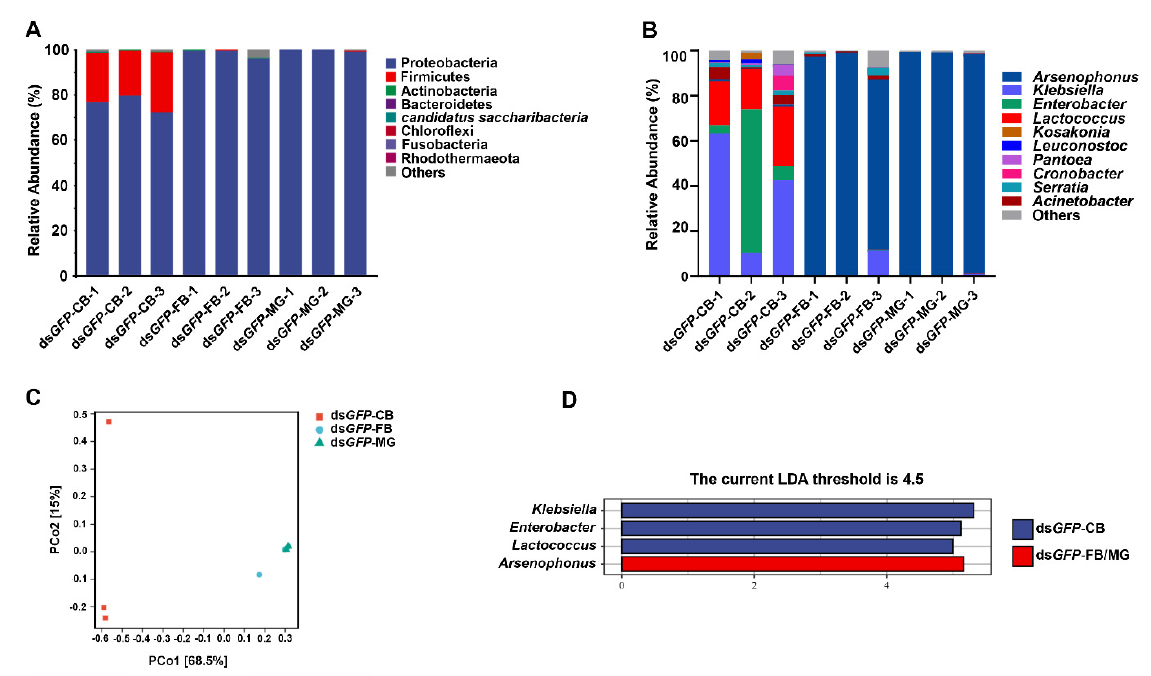
Figure 6. ( A – B ) Proportional compositions of microbiome in copulatory bursa (CB), fat body (FB), and midgut (MG) of N. lugens treated with ds GFP . Composition at the phylum ( A ) and genus ( B ) levels. The 10 species with the highest relative abundances were displayed, and the relative abundances of the remaining species were combined and grouped into Others; ( C ) Principal coordinates analysis (PCoA) plot of the Bray–Curtis distance based on the microbial structure in CB, FB, and MG; ( D ) LDA Effect Size (LEfSe) analysis based on ASV abundance in CB, FB, and MG. CB: copulatory bursa; FB: fat body; MG: midgut. For microbial taxon numbers, see Table S2.